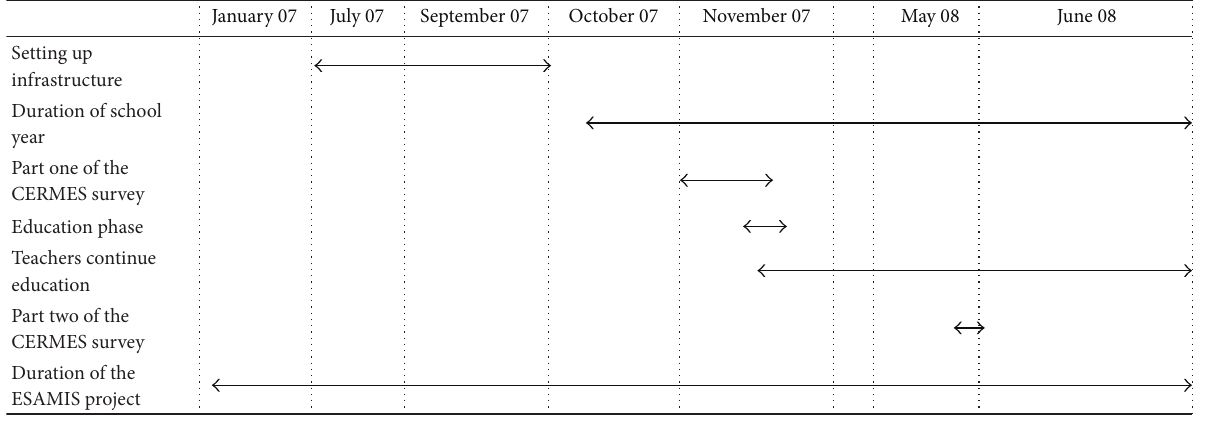
Table 1: Timetable of activities: ESAMIS project and CERMES